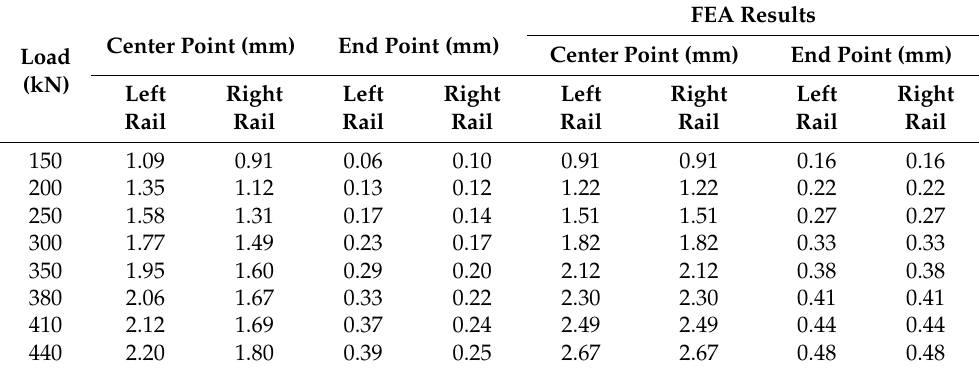
was 0.06 to 0.39 mm, and 0.10 to 0.25 mm for the right rail. Thus, the average displacement of the rails mounted on three-panel at the center point was approximately 8.30 times larger than at the endpoint. Table 5. Maximum relative rail displacement results for the three-panel precast floating slab track (loading at center point of 2nd Panel). Center Point (mm) End Point (mm) Load (kN)